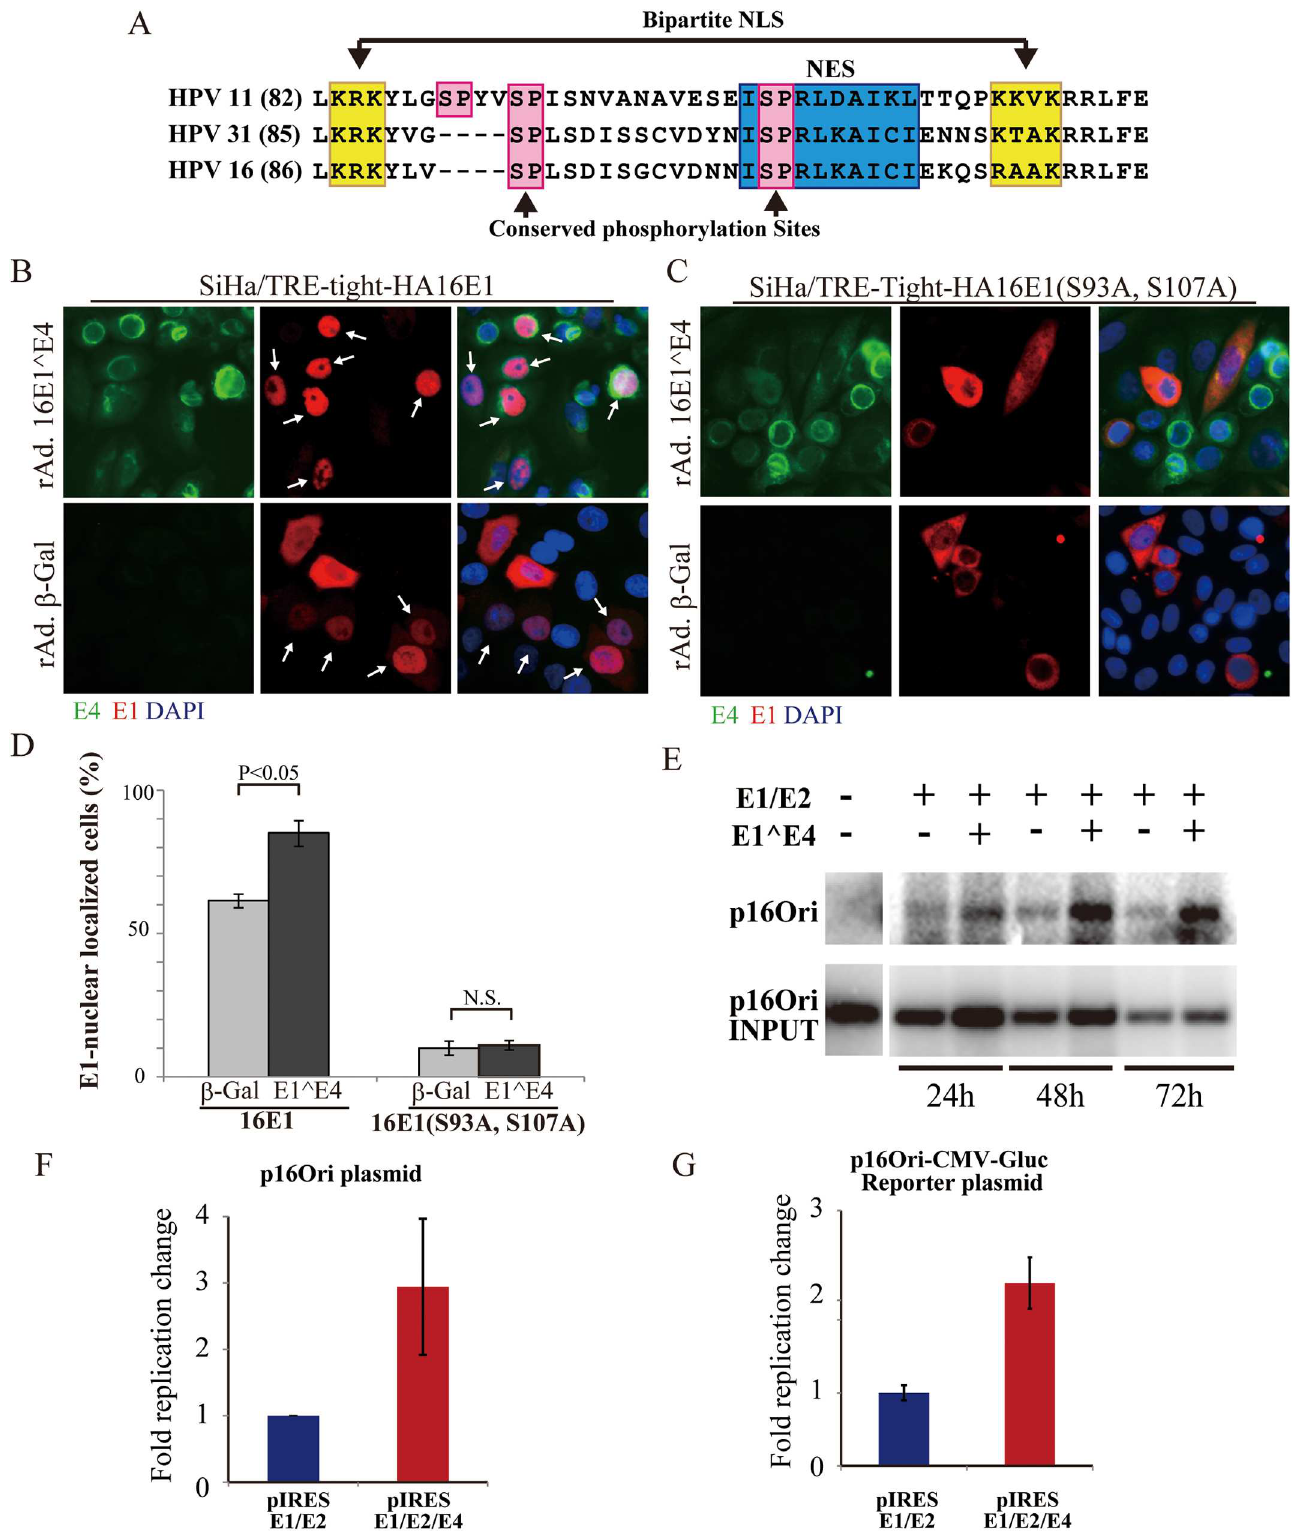
Fig 8. 16E1^E4 expression drives nuclear accumulation of wild type but not mutant 16E1 and enhances E1/E2-mediated HPV16 ori- dependent replication. (A) Sequence alignmentshowingthe locationof conservedMAPK phosphorylation sites involvedin regulatingE1 nuclear/